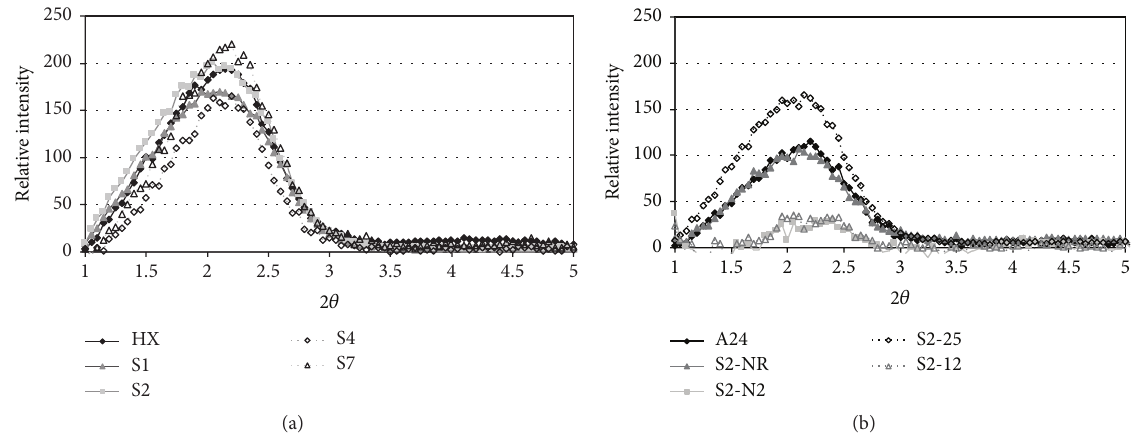
Figure 1: XRD patterns obtained for (a) HX, S1, S2, S4, and S7 and (b) A24, S2-NR, S2-N2, S2-25, and